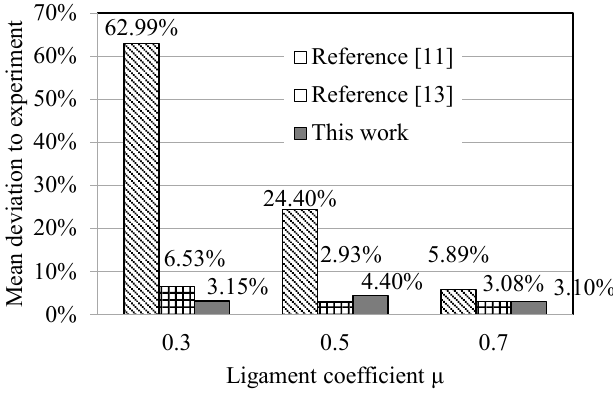
Figure 12. Comparisons of capacitance between experiment and formulae, summary of Tables 6–8.